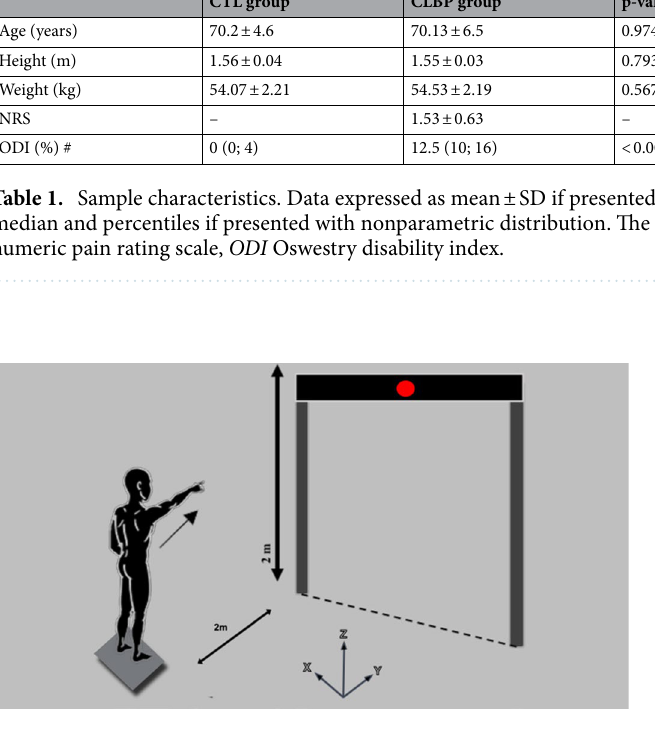
Figure 1. Experimental setup for task showing a participant in final posture. Central diode of the bar was placed exactly in front of participants’ right shoulder. Participants were asked to point their index finger, with extended elbow, at the central diode whenever it was turned